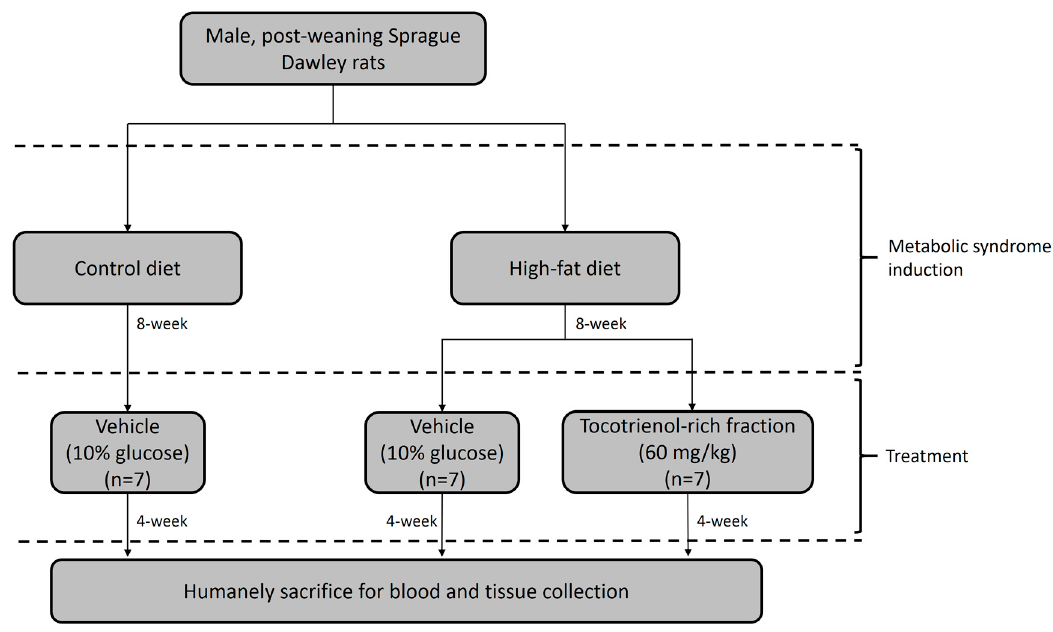
Figure 1. Experimental design of the present study.